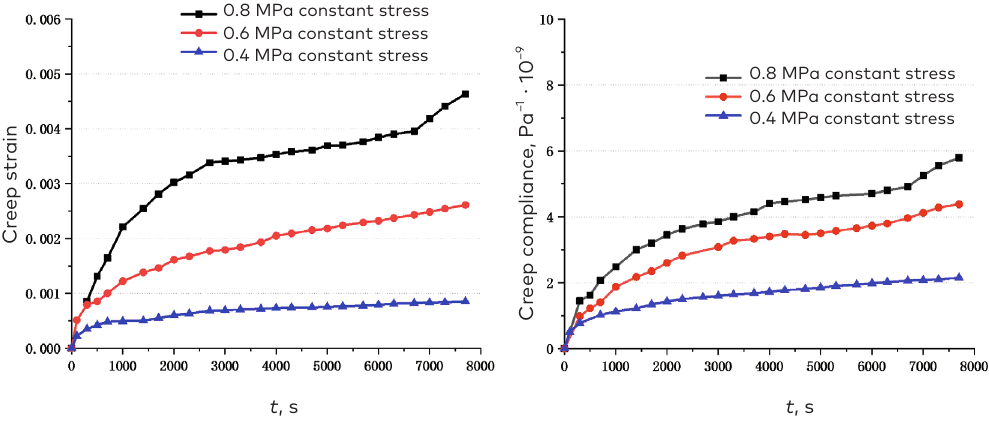
a) curves of creep strain with time